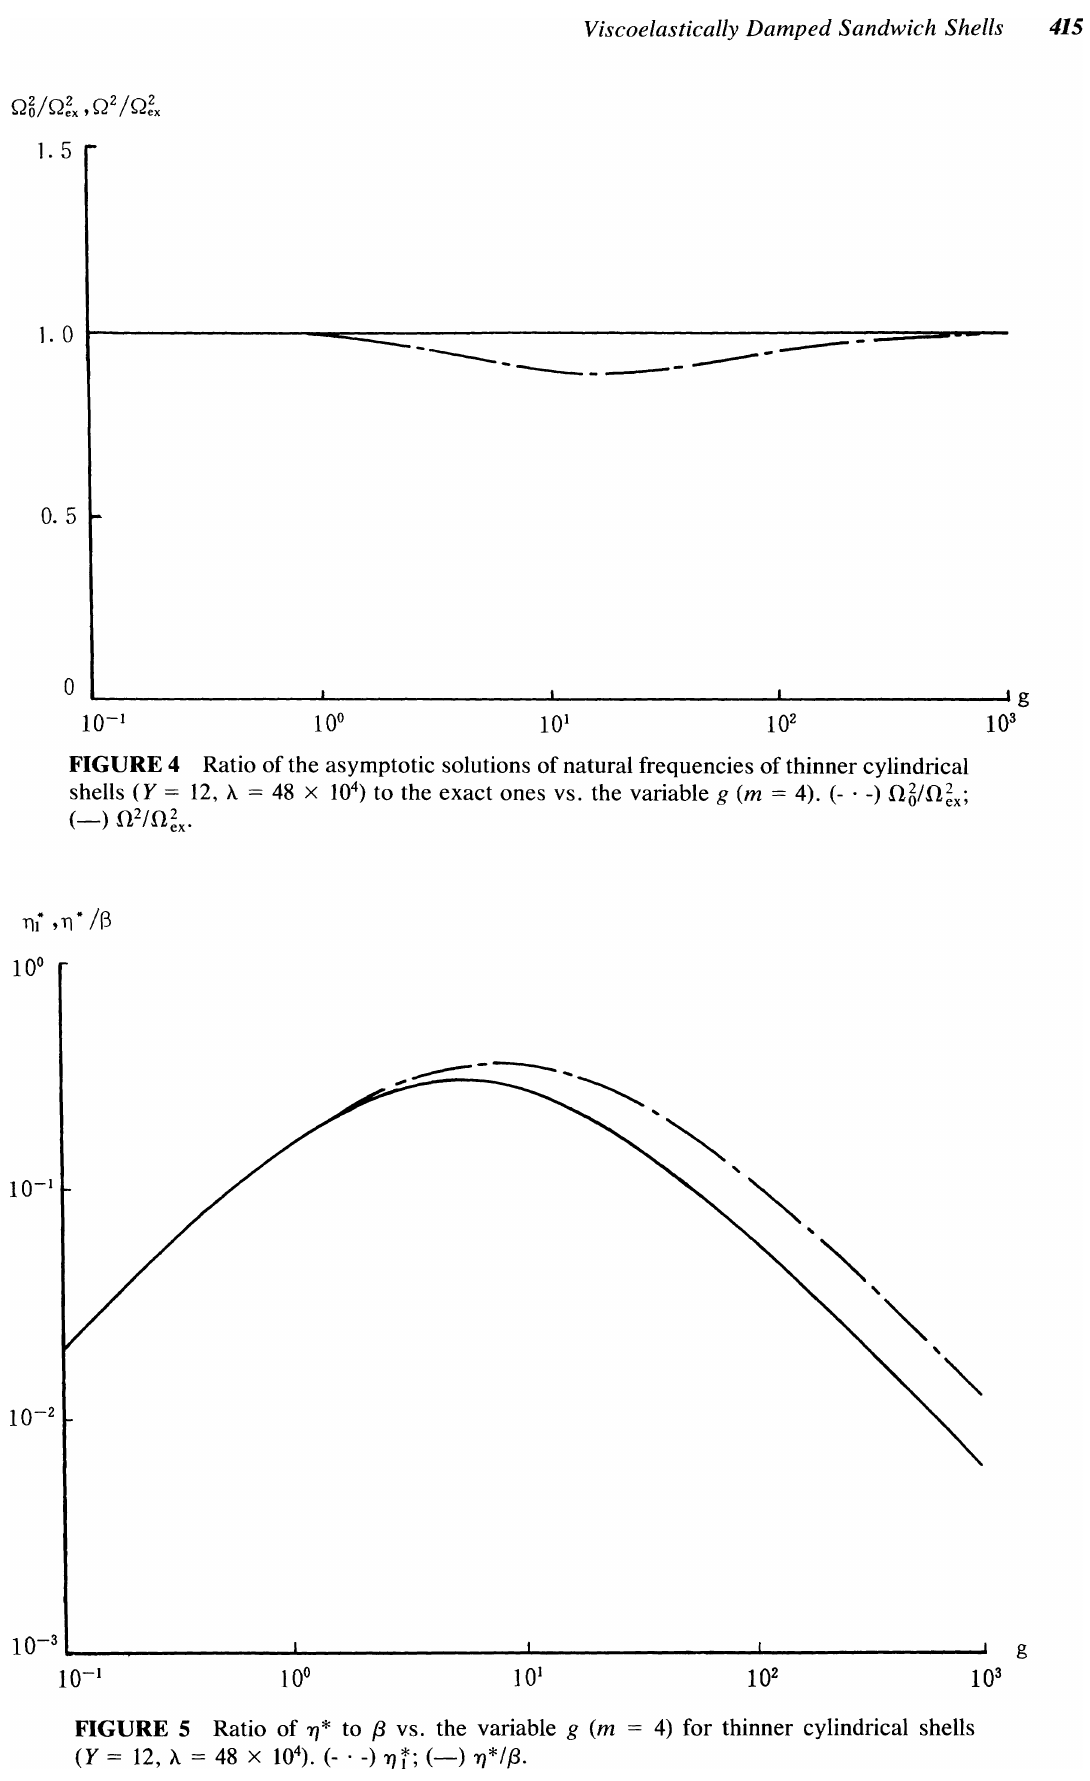
FIGURE 5 Ratio of 71* to f3 vs. the variable g (m = 4) for thinner cylindrical shells (Y = 12, A. = 48 X 10 4). (- . -) 'Y/T; (-)